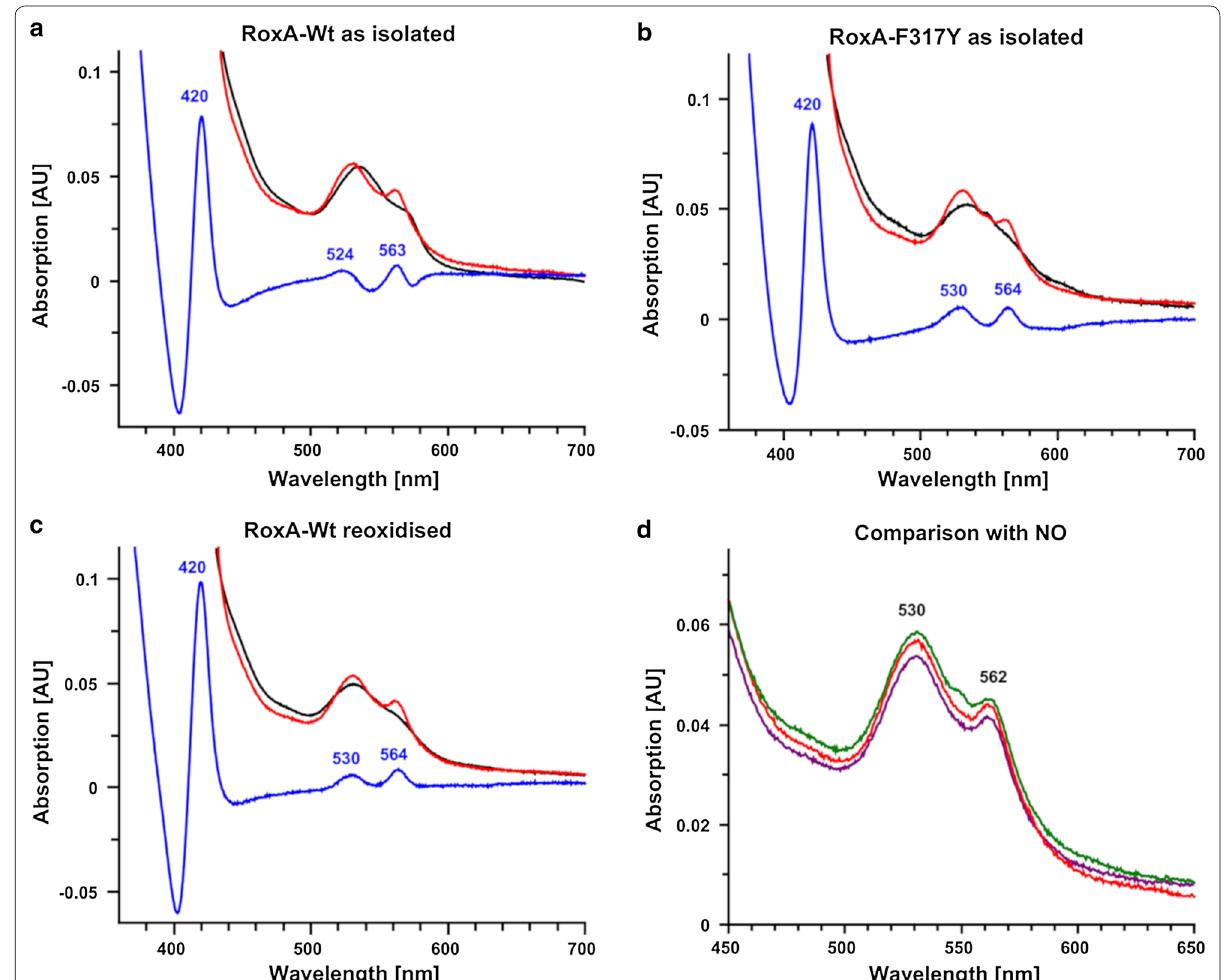
Fig. 3 UV–vis spectra of RoxA variants in the presence of NO. The original spectra (black) of RoxAWt ( a ), RoxA F317Y ( b ) and (ferricyanide-)reoxidised RoxA-Wt ( c ) are compared with the spectra in NO-saturated buffer (red); the difference spectra (RoxA (fully oxidised) preparation in b , c show basically identical difference maxima while RoxA-Wt as isolated results in slightly distinct difference maxima caused by the presence of the oxygenated haem. d A direct comparison of the UV–vis Q-band region of all three preparations in presence of NO visualises their identity, however, suggesting that also the ferrous–O 2 -haem of RoxA as isolated (red) reacts to the same ferric NO-species as in oxidised RoxA-Wt (purple) and RoxA-F317